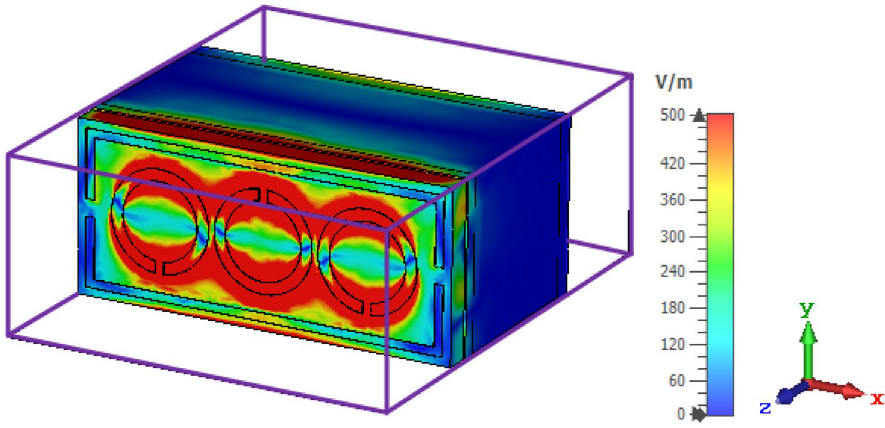
Figure 5. E-field distribution for the proposed MTM sensor.